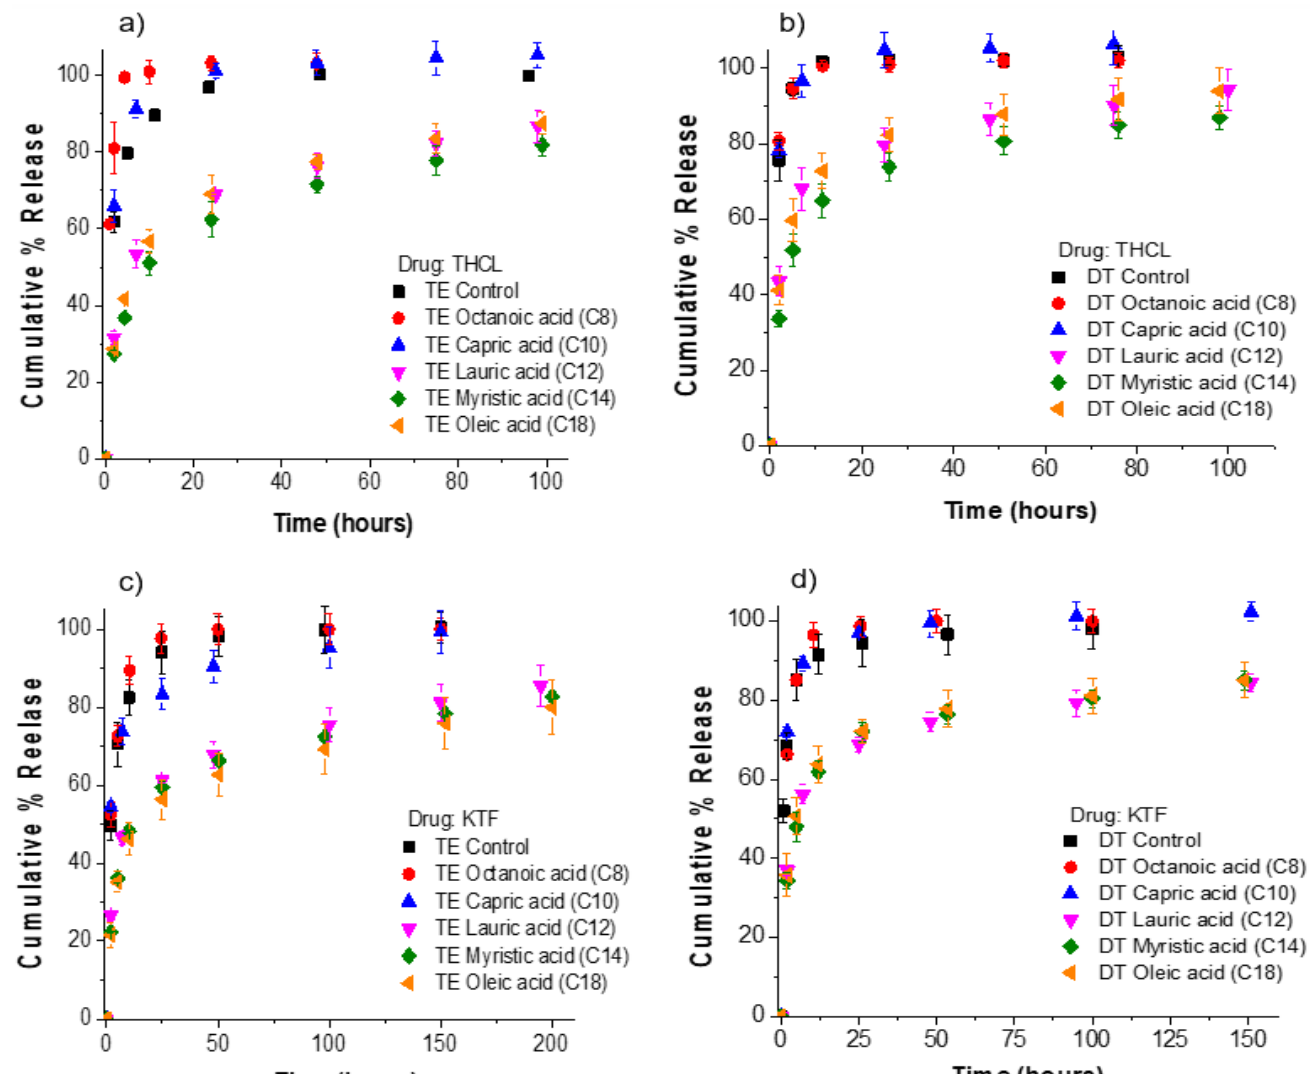
Figure 3. Cumulative % release of KTF and THCL from silicone hydrogel commercial lenses. Fatty acids in contact lenses were loaded at a fixed soaking concentration of 25 mM. The total amount of drug uptake for each fatty-acid-loaded lens case is displayed in Figure 2. ( a ) THCL cumulative % release from ACUVUE TruEye ® . The total amount of drug uptake: 120.3 ± 4.0 µg for control lenses. ( b ) THCL cumulative % release from Dailies Total1 ® . The total amount of drug uptake: 99.4 ± 1.7 µg for control lenses. ( c ) KTF cumulative % release from ACUVUE TruEye ® . The total amount of drug uptake: 211.1 ± 13.0 µg for control lenses. ( d ) KTF cumulative % release from Dailies Total1 ® . The total amount of drug uptake: 152.8 ± 7.1 µg for control lenses Data are presented as mean +/- standard deviation with n = 3.